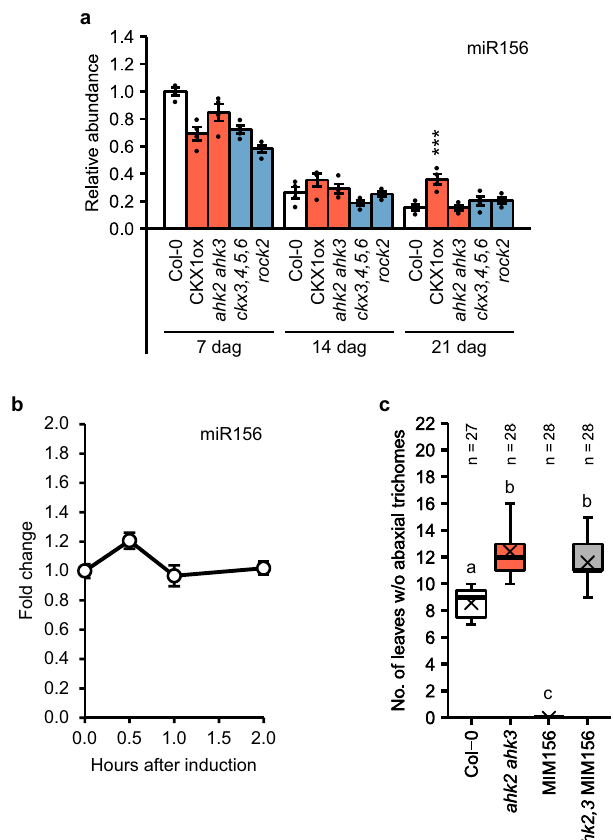
Fig. 3 The effect of cytokinin on the juvenile-to-adult phase transition is not dependent on miR156. a miR156 abundance in whole shoots of genotypes with an altered CK status compared to the wild type ( n = 4 biological replicates). Dots indicate each single biological replicate. Asterisks indicate signi fi cant differences compared to the wild type of the respective time point, as calculated by one-way ANOVA, post-hoc Dunnett ’ s test (* p < 0.05; ** p < 0.01; *** p < 0.001). See also Supplementary Fig. 2a. b miR156 expression kinetics in 10-days-old SD-grown wild-type seedlings after treatment with 1 µ M BA ( n = 6 biological replicates). Statistical analysis was performed using one-way ANOVA, post-hoc Dunnett ’ s test. No statistically signi fi cant differences were observed for miR156, comparing each time point with time point 0 ( p < 0.05). Transcript levels ( a , b ) were determined by qRT-PCR. Data were normalized to TAFII15 . Data displayed are expressed as mean ± SEM. c Number of leaves without abaxial trichomes in ahk2 ahk3 MIM156 hybrid plants grown in SD. In the box plot, the center line represents the median value and the bounderies indicate the 25th percentile (upper) and the 75th percentile (lower). The X marks the mean value. Whiskers extend to the largest and smallest value, excluding outliers which are shown as dots. Letters indicate signi fi cant differences between the genotypes, as calculated by Kruskal – Wallis test ( p < 0.05). Exact p -values calculated for a – c are included in the Source Data fi